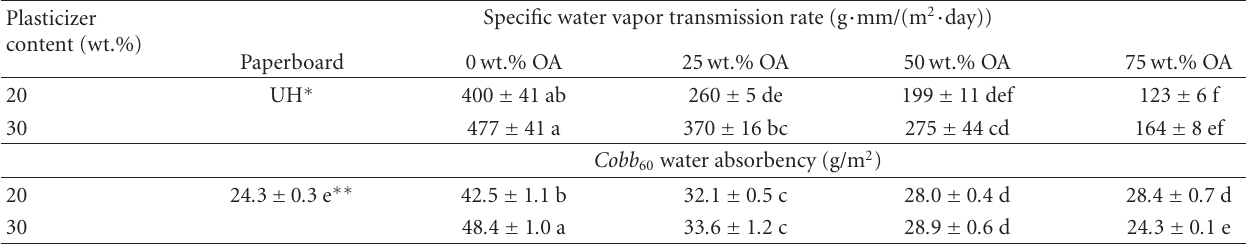
Table 1: Water vapor transmission rate and surface water